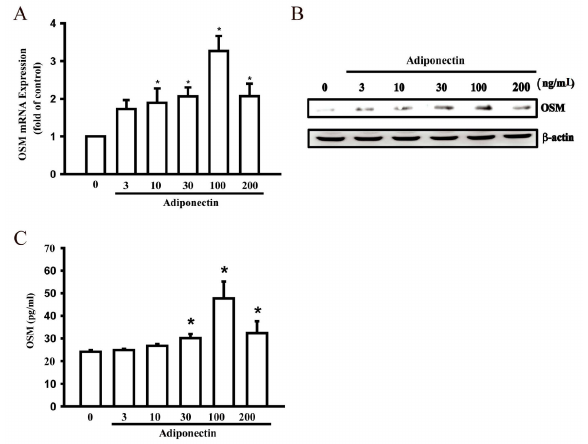
Figure 1. Adiponectin increases oncostatin M (OSM) production in human osteoblasts. ( A ) Osteoblastic cells were incubated with various concentrations of adiponectin (3–200 ng/mL) in OSM mRNA expression and were measured by quantitative polymerase chain reaction (qPCR) ( n = 6); ( B ) Cells were incubated with various concentrations of adiponectin (3–200 ng/mL) and OSM protein levels were measured by Western blot ( n = 4); ( C ) Osteoblasts were stimulated with adiponectin (3–200 ng/mL) for 24 h and the supernatant medium was collected and analyzed by enzyme-linked immunosorbent assay (ELISA) ( n = 5). Results are expressed as mean ˘ standard error of mean S.E.M. *, p < 0.05 compared with